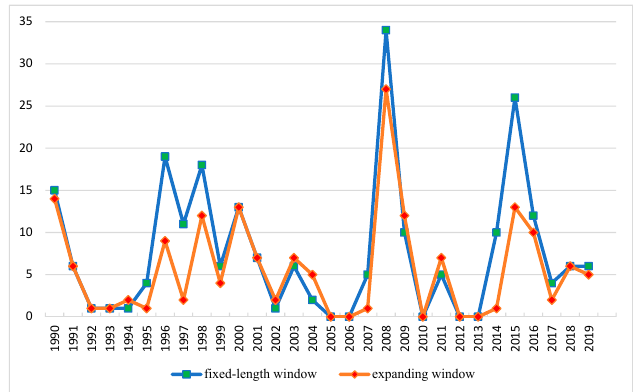
Figure 1. Number of crude oil market crashes for daily data (exceedance less than 2.5% percentile of the empirical distribution). Note: The fixed-length window means the length of the window was fixed at 1000 days, and the expanding window means the length of window increased from 1000 days to 8151 days. The total daily data was